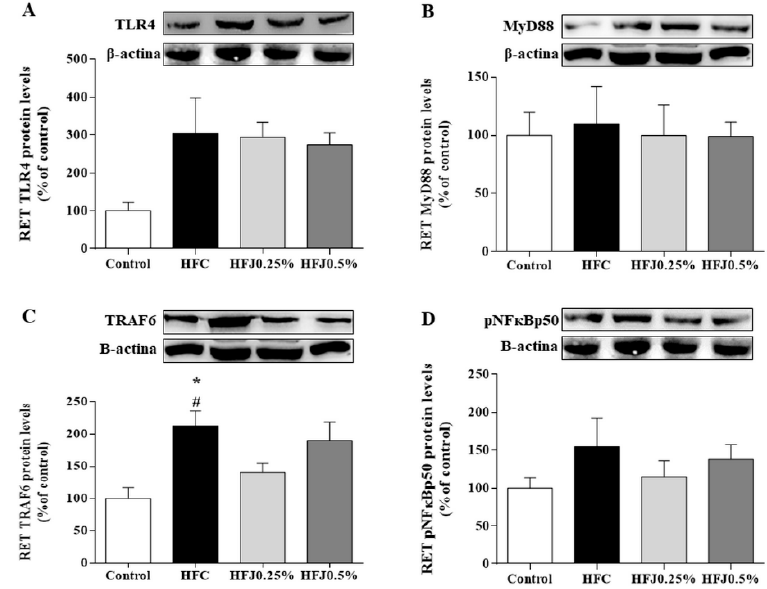
Figure 4. Protein expression of the NF κ B pathway in the RET: ( A ) TLR4; ( B ) MYD88; ( C ) TRAF6; and